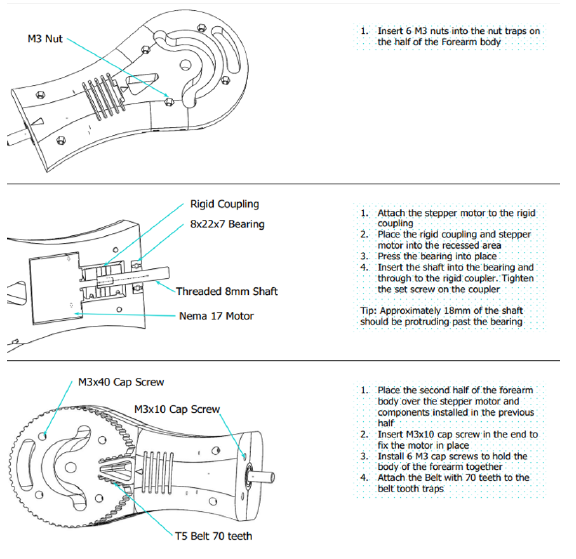
Fig. 4. Design for forearm assembly